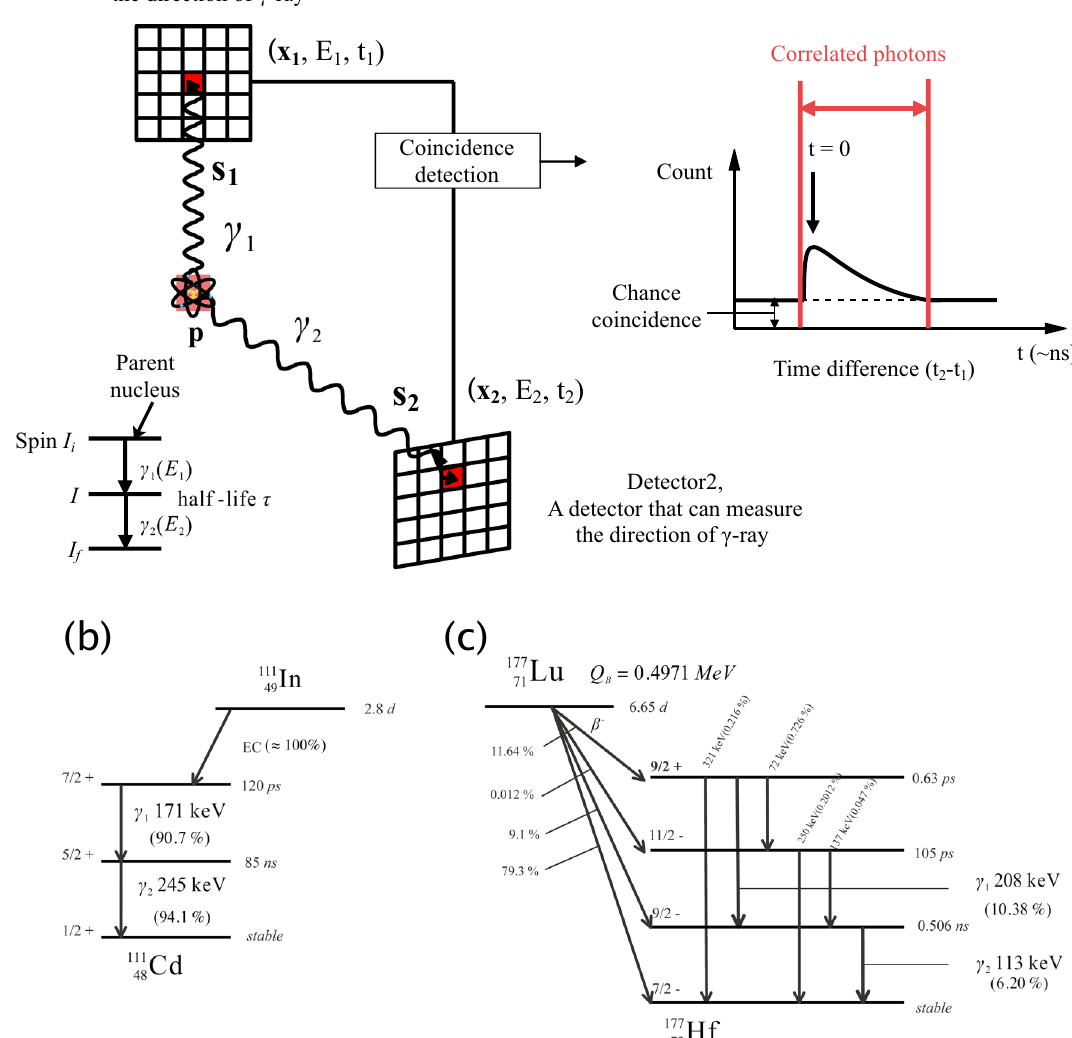
Figure 1. Principle of the double photon coincidence imaging and decay scheme of 111 In and 177 Lu. ( a ) The conceptual schematic of the double photon coincidence imaging. ( b ) 111 In decay scheme. Two gamma rays with 171 and 245 keV energies are emitted through the intermediate level with 85 ns duration after electron capture. ( c ) 177 Lu decay scheme. 177 Lu emits beta rays and some gamma rays. Gamma rays with 208 and 113 keV energies are mainly emitted through the intermediate level with 0.506 ns duration. Figure ( a ) was created using the software (Wondershare EdrawMax, v.10.1.5, https:// www. edraw soft.